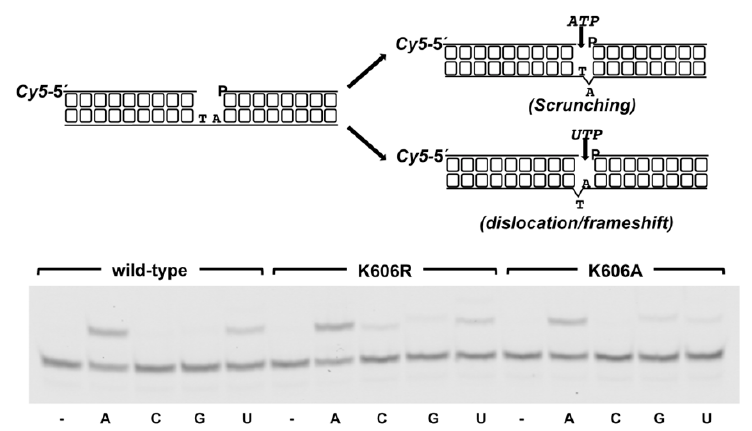
Figure 8. Selection of the templating base by Pa -PolDom wild-type and mutants K606R and K606A. Gap-filling reactions were performed as described in Materials and Methods using 5 nM of the depicted 2 nt gapped DNA substrate, 10 nM (wild-type and K606R) and 30 nM (K606A) Pa -PolDom and 10 nM of the indicated NTP . After incubation at 30 ◦ C for 5 min, products were resolved by denaturing PAGE and further visualized using a Typhoon 9410 scanner (GE Healthcare).